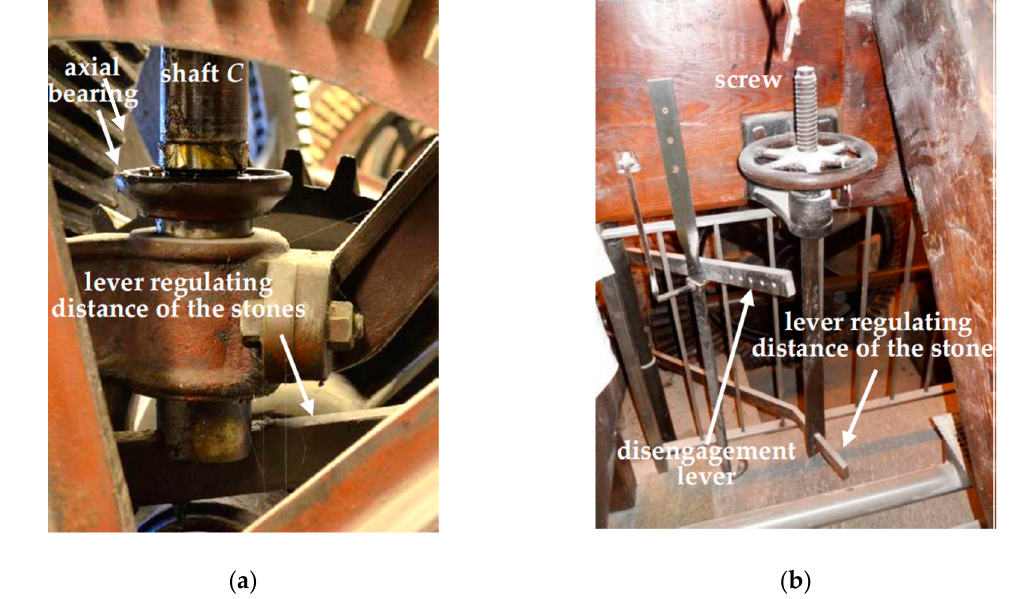
Figure 18. Stone distance regulation mechanism of the Riviera mill: ( a ) Axial bearing; ( b ) lead screw mechanism.